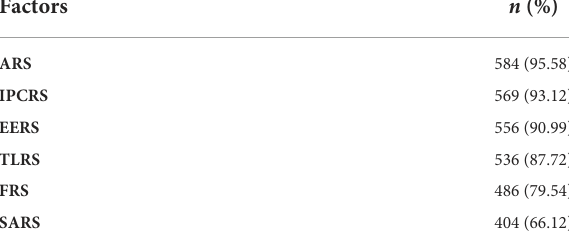
TABLE 5 Proportion of students who indicated stress related to specific factor * .